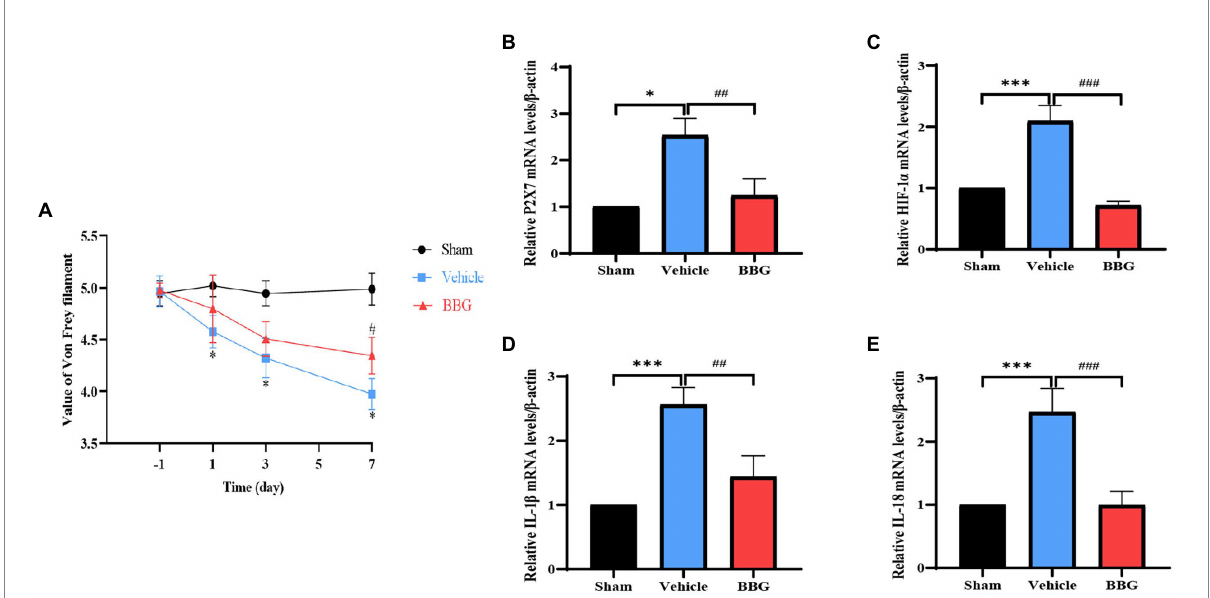
FIGURE 6 Effects of Brilliant Blue G (BBG) on pain behaviors and the expression of P2X7, HIF-1 α , and inflammatory factors. (A) The pain threshold of the sham, vehicle and BBG rats. * p < 0.05 vs. sham, # p < 0.05 vs. vehicle. (B) The effect of dental pulp exposure and BBG treatment on mRNA level of P2X7 in MDH. * p < 0.05 vs. sham, ## p < 0.01 vs. vehicle. (C) The effect of dental pulp exposure and BBG treatment on mRNA level of HIF-1 α in MDH. *** p < 0.001 vs. sham, ### p < 0.01 vs. vehicle. (D) The effect of dental pulp exposure and BBG treatment on mRNA level of IL-1 β in MDH. *** p < 0.01 vs. sham, ## p < 0.01 vs. vehicle. (E) The effect of dental pulp exposure and BBG treatment on mRNA level of IL-18 in MDH. *** p < 0.001 vs. sham, ### p < 0.01 vs.